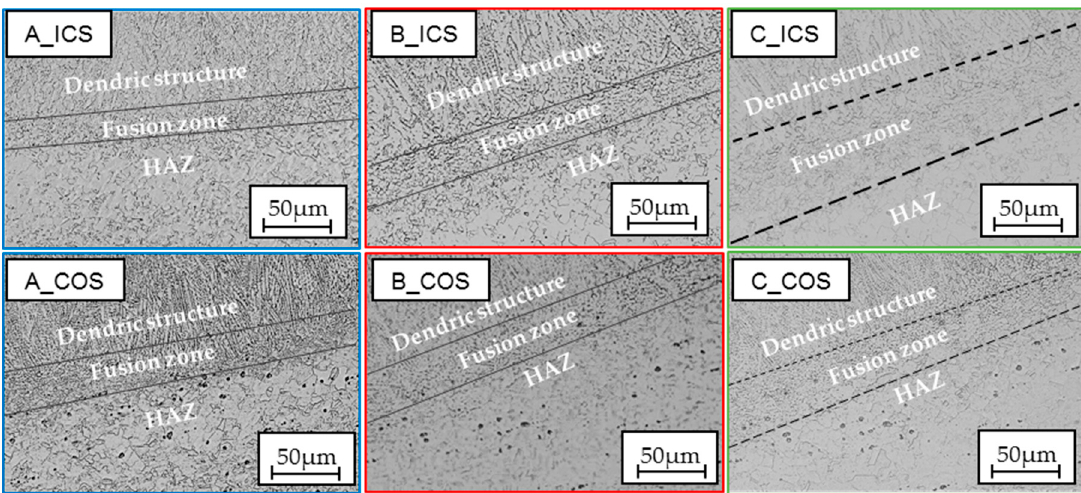
Figure 9. Optical microscopic images microstructure of substrate (base plate) in cross-section view and transition grain structure of the IN718 wall for ICS and COS using both processing parameters.